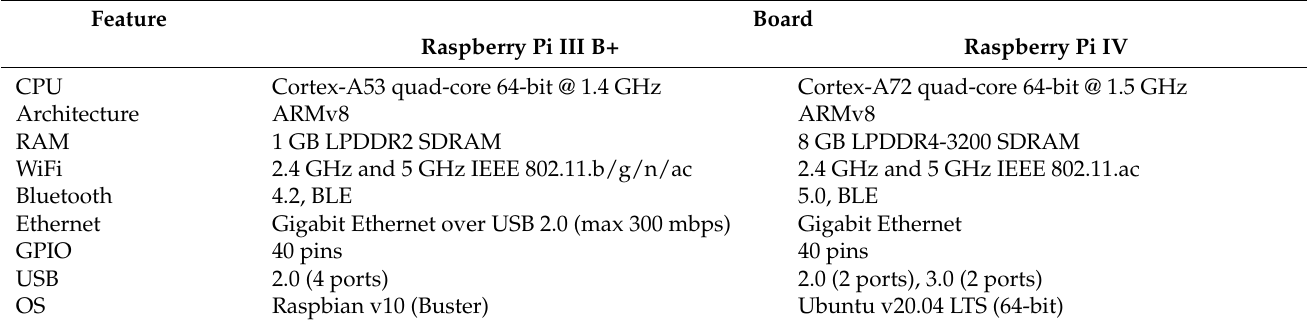
Table 6. Raspberry Pi boards’ main characteristics.